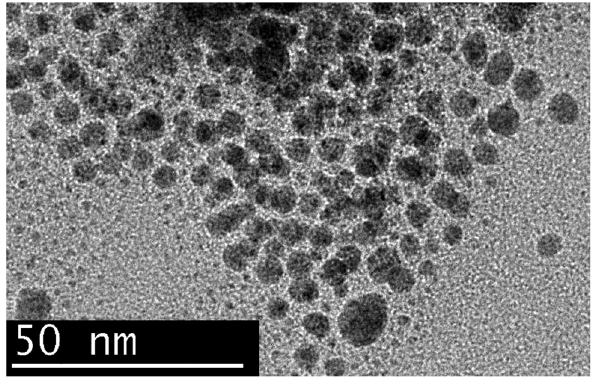
Figure 2: TEM micrograph of the phytosynthesized Se - NPs with